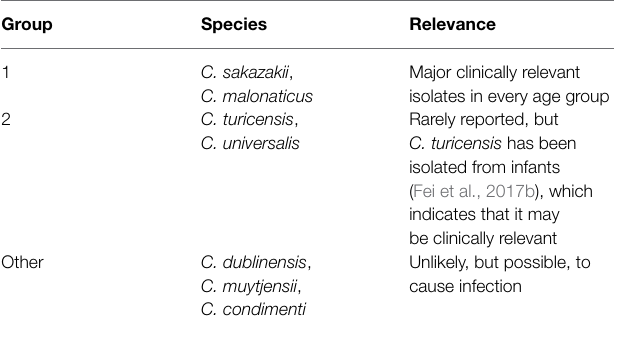
TABLE 1 | Clinical relevance of Cronobacter species (adapted from Forsythe,